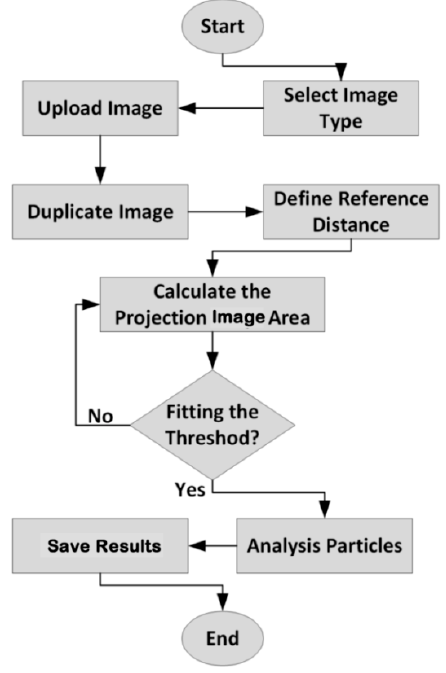
Figure 3. Flowchart of the ImageJ using to measure the projected area.